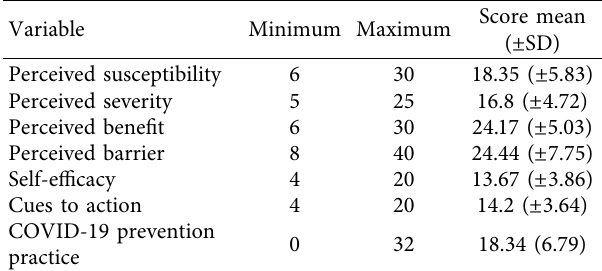
University of Gondar, Ethiopia, 2021 ( n �